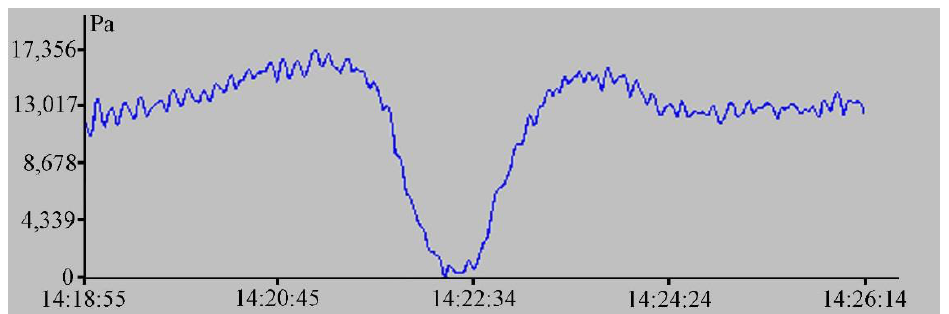
Figure 9. A section of the recording of the supersensitive detector of hydrosphere pressure variations for 1 June 2021, installed on the seabed at the Cape Shultz, showing a nonlinear hydrophysical disturbance corresponding to a rogue wave of the “ sea pit ” type.